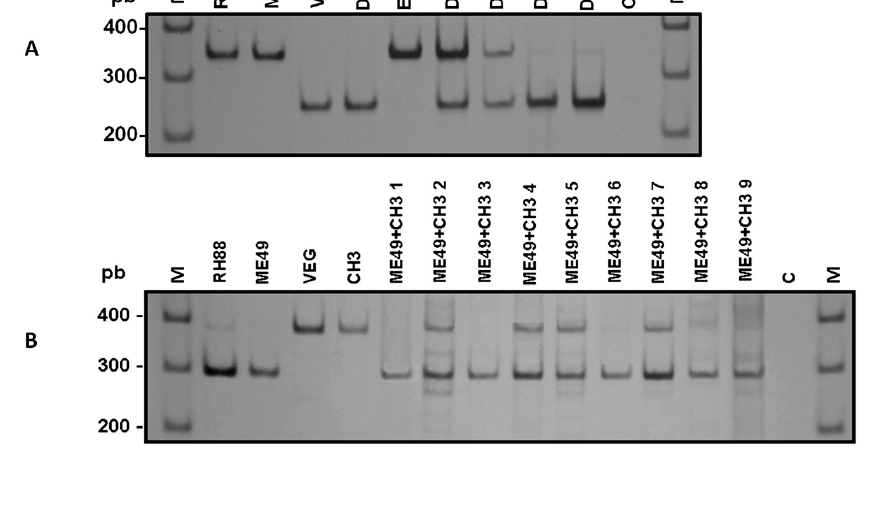
Fig. 2. – Specific IgA antibodies to Toxoplasma gondii detected by ELISA in sera of non-immunosuppressed BALB/c mice, primary infected with D8 strain and challenged after 45 days with the CH3 or EGS strains (groups 1 and 3, respectively) and non-immunosuppressed BALB/c mice, primary infected with the ME49 strain and challenged after 45 days with the CH3 or EGS strains (groups 10 and 12, respectively). Control groups were infected with the D8 strain (group 5) and ME49 (group 14) and